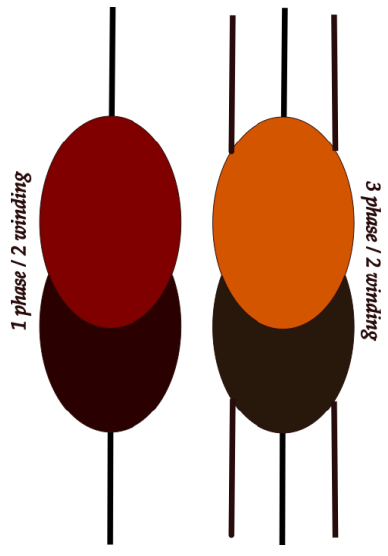
Figure 2. The transformer types.